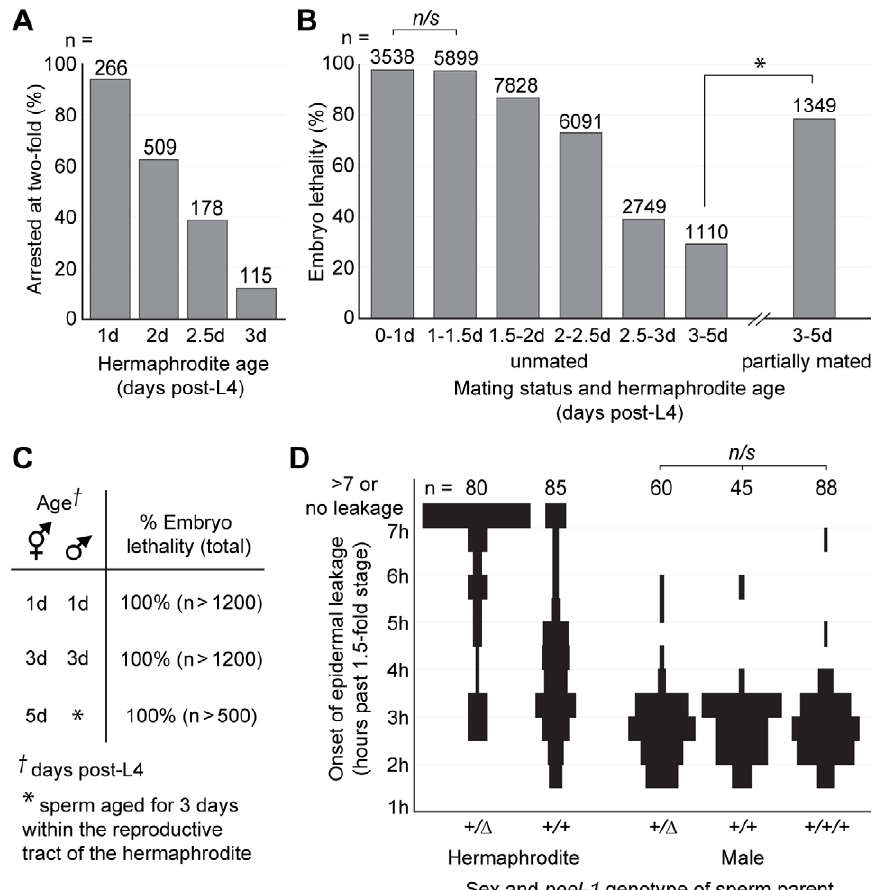
Figure 5. The phenotypic effects of sperm-supplied PEEL-1 are dose-dependent. (A) The proportion of embryos arresting at the 2-fold stage was calculated among peel-1 -affected embryos sired by 1- to 3-d-old hermaphrodites. Within each age class, embryos derive from a total of approximately 50 to 150 hermaphrodites. All pair-wise combinations of age classes were compared using x 2 tests. For all pairs, p , 10 2 5 . (B) Embryo lethality was scored among peel-1 -affected embryos sired by unmated, 1- to 5-d-old hermaphrodites and by partially mated, 3- to 5-d-old hermaphrodites. In the unmated experiment, 91 hermaphrodites were followed from the onset of adulthood, and all embryos laid during the first 5 d of adulthood were scored. The results for 10 randomly selected broods are shown in Figure S4. To generate embryos sired by partially mated animals, 130 hermaphrodites were briefly mated to males following the L4 molt, and embryos were collected during days 3 to 5 from the 35 hermaphrodites that produced a mixture of self- and cross-progeny. Self- and cross-progeny were distinguished by the use of an integrated GFP marker carried by the male, and cross-progeny were excluded from analysis. x 2 tests were used to compare the unmated and partially mated ‘‘3–5d’’ age classes, as well as all pair-wise combinations of age classes within the unmated experiment. n/s , p . 0.05. * and all unlabeled pairs within the unmated experiment, p , 10 2 5 . (C) Embryo lethality was scored among peel-1 -affected embryos derived from crosses between (i) 1-d-old males and hermaphrodites, (ii) 3-d- old males and hermaphrodites, and (iii) 5-d-old hermaphrodites that had been removed from males on day 2 in order to allow male sperm to age for 3 d within the reproductive tract of the hermaphrodite. In each cross, embryos derive from a total of 12 to 16 hermaphrodites. (D) Spindle plots showing the onset of epidermal leakage in peel-1 -affected embryos sired by hermaphrodites carrying one or two copies of peel-1( + ) , or by males carrying one, two, or three copies of peel-1( + ) . A third copy of peel-1 was added using the single-copy insertion of the peel-1 transgene marked in Figure 1B. The width of each bar reflects the proportion of embryos initiating leakage in each time interval. All pair-wise combinations of spindle plots were compared using Mann-Whitney U tests on the raw distributions of leakage times. n/s , p . 0.05. For all other pairs, p , 10 2 5 . epidermal leakage ( n = 120 embryos; Figure 4G). (Muscle detachment and excretory cell distention could not be assayed because muscle movement, combined with epidermal leakage, ripped embryos apart entirely.) Conversely, expression of zeel-1 only in the epidermis rescued the epidermal defects, but it did not rescue paralysis and 2-fold arrest ( n = 69 embryos; Figure 4H). In hermaphrodite-sired embryos, both constructs fully rescued a subset of embryos, and rescue activity increased with hermaph- rodite age (Figure S6). This result is consistent with the age effect among hermaphrodite-sired embryos and the fact that hermaph- rodite-sired embryos do not always exhibit defects in both muscle and epidermal tissue.